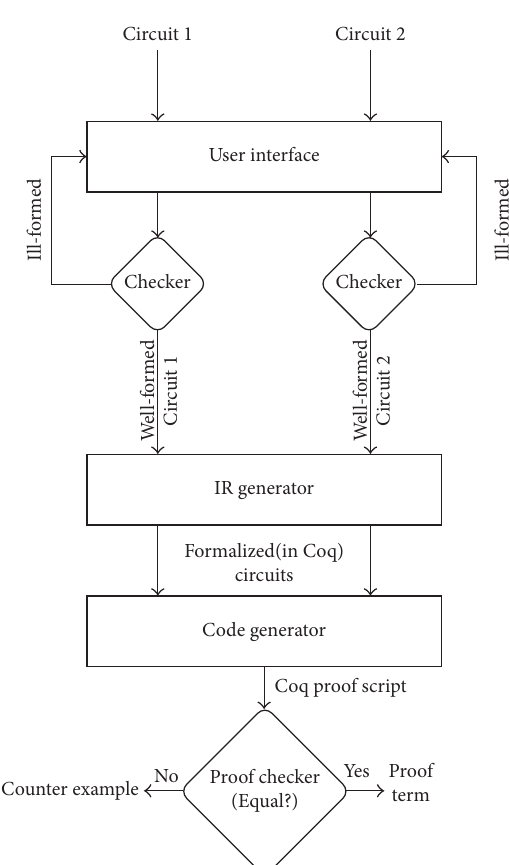
Figure 9: Schematic diagram of the CoCEC tool.